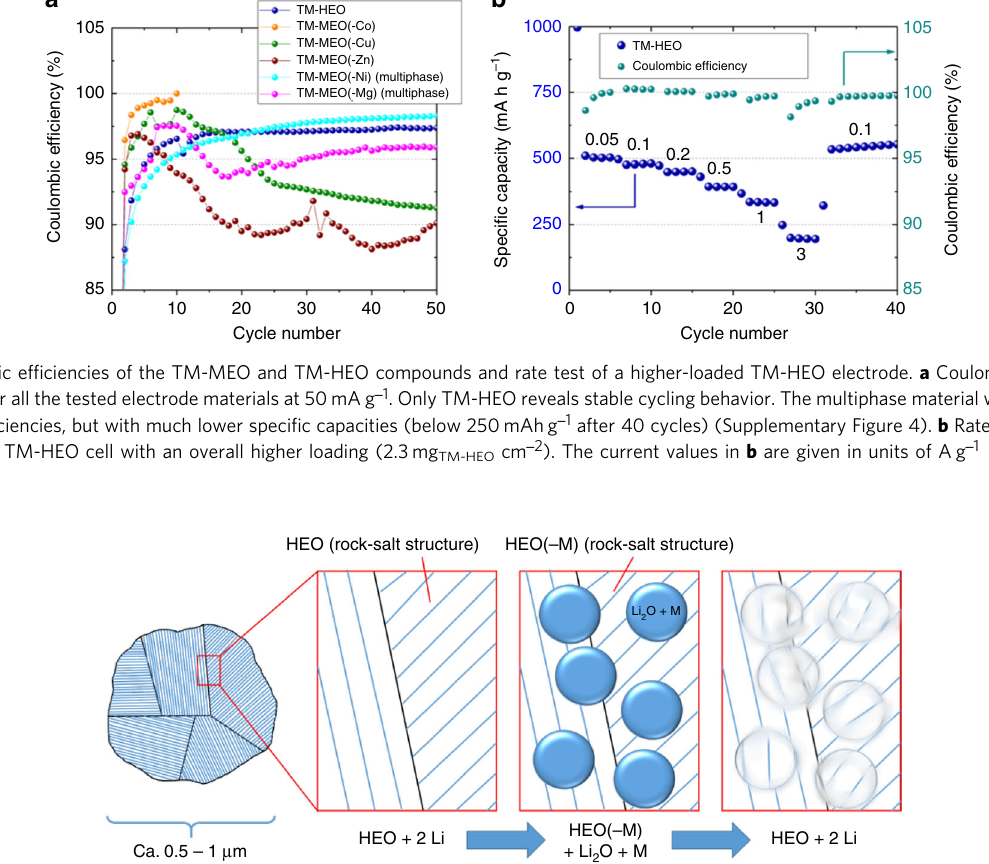
at 1150 °C. For the 5-cation system, a single-phase structure was obtained directly during the synthesis process. By contrast, the 4-cation systems (see Table 1) required a post annealing treatment (1 h at 1000 °C under ambient atmosphere) to form a single-phase compound. This annealing step was also applied to the 5- cation system, to make sure that all the compounds had the same synthesis/heat treatment history to facilitate comparison of the electrochemical properties among the different systems.